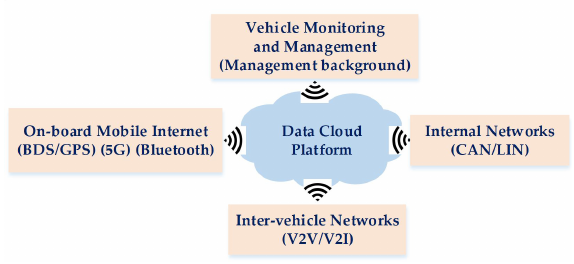
Figure 15. The architecture of